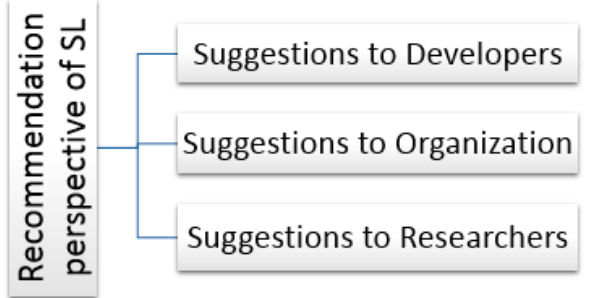
Figure 21. Recommendation perspective of sign language.